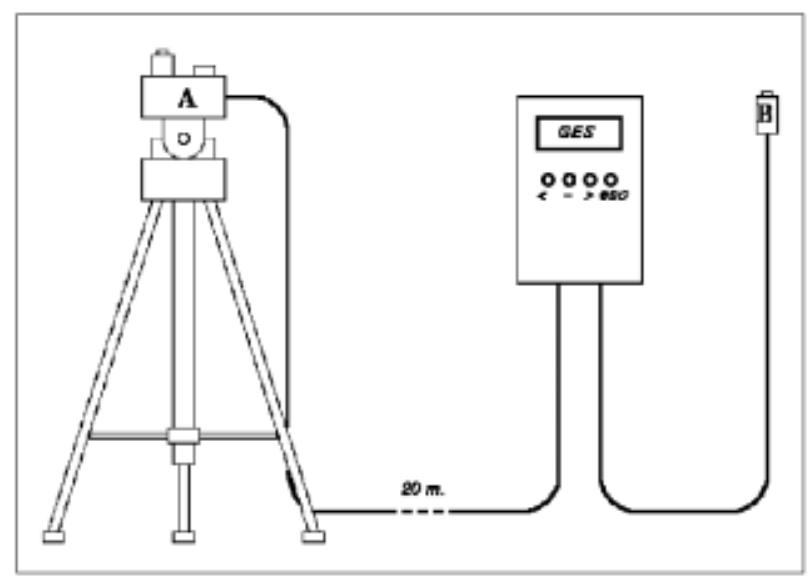
Fig. 2. The Gap Estimation Sys- tem. The sensor on the tripod (A) is the referential PAR sensor put in the gap center. The remote sensor (B) gives relative light readings from paired synchronic light meas- urements. The readings are saved in the data-logger for later download to a computer